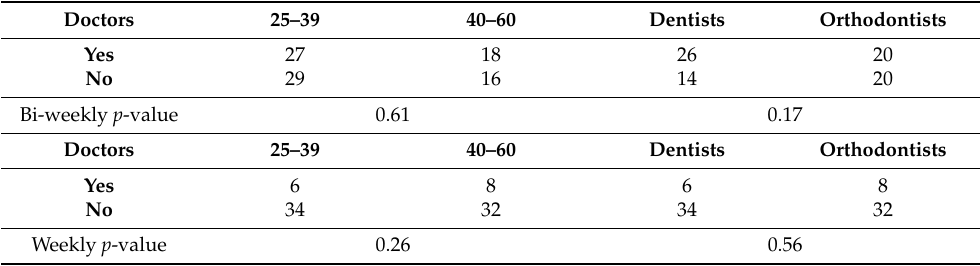
Table 1. Chi-square tests performed among the orthodontists, investigating the correlation between age and availability to take/examine pictures bi-weekly or weekly, respectively.